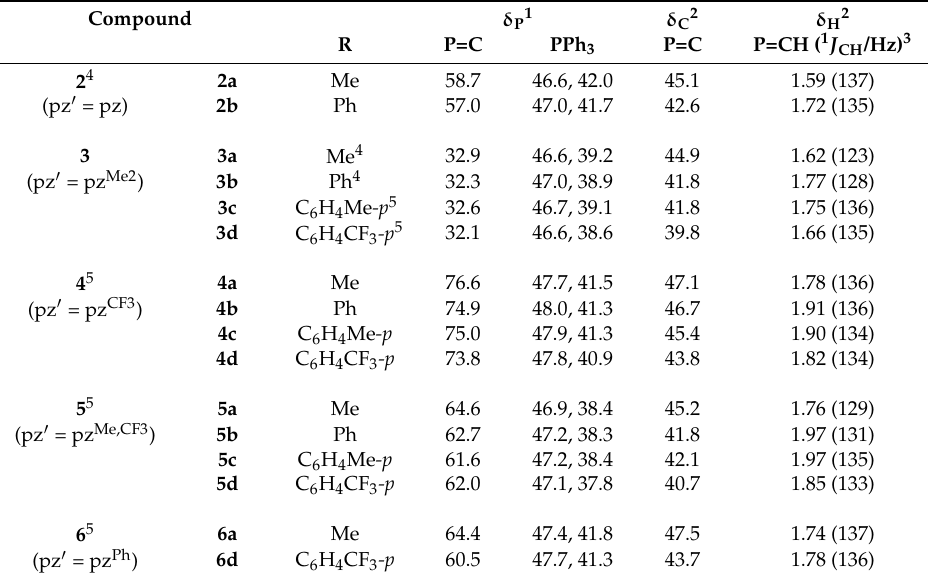
Table 1. NMR Spectroscopic data for [Ru{ η 1 - N : η 2 - P,C -P(pz (cid:48) )=CH(SiMe 2 R)}Cl(CO)(PPh 3 ) 2 ].